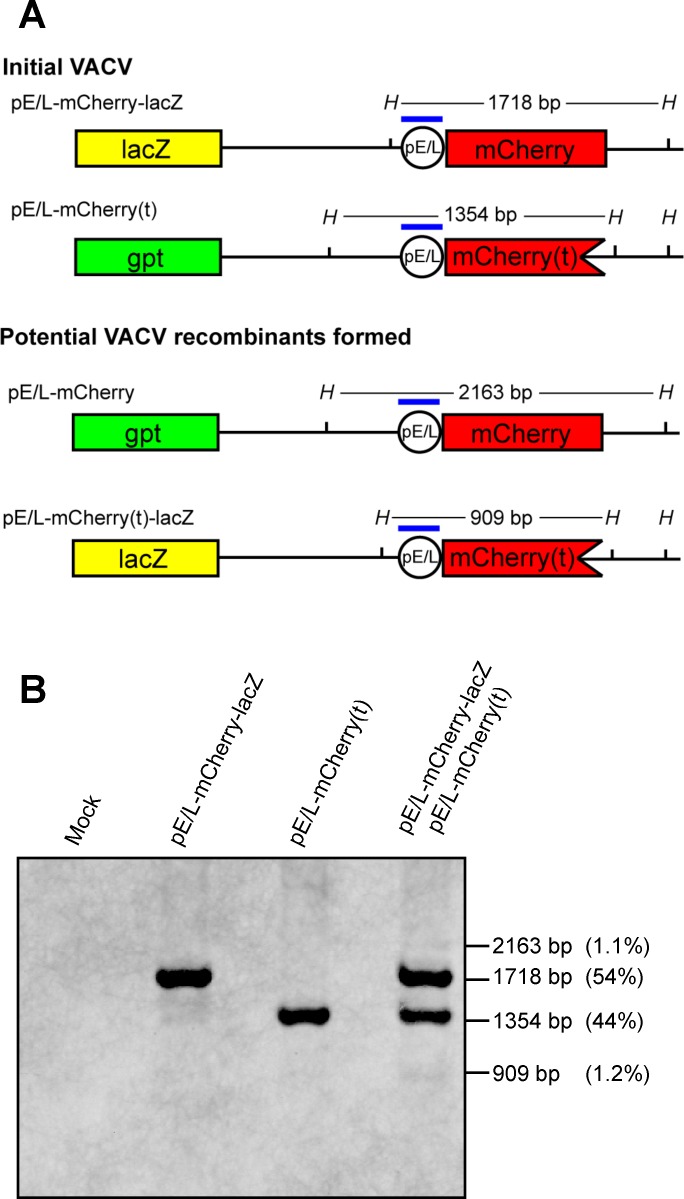
Recombination between pE/L-mCherry(t) and pE/L-mCherry-lacZ viruses.(A) The figure shows the two parent viruses, the predicted recombinants, and the HindIII fragments that should be detected by the pE/L oligonucleotide probe (blue bar). (B) Southern blot analysis of cells co-infected with the pE/L-mCherry(t) and pE/L-mCherry-lacZ viruses. BSC-40 cells were infected with each of the parental viruses at MOI = 5, or co-infected with the two viruses at a combined MOI = 5, and the DNA was extracted 24 h post-infection. The samples were then Southern blotted using a biotin-labeled probe. Although faint, two bands at 2.2 and 0.9 kbp are seen that indicate the presence of recombinant genomes. Collectively they comprise about 2% of the DNA.